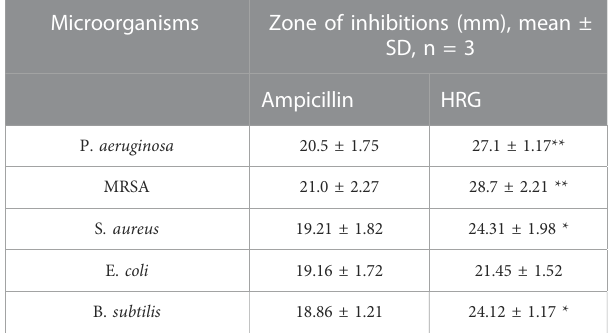
FIGURE 6 SEM analysis of highly reduced graphene oxide (HRG). TABLE1ZOIresultsfromagardiffusiontestbyHRG,ascomparedtoampicillin. Results were presented as mean ± SD, n = 3.